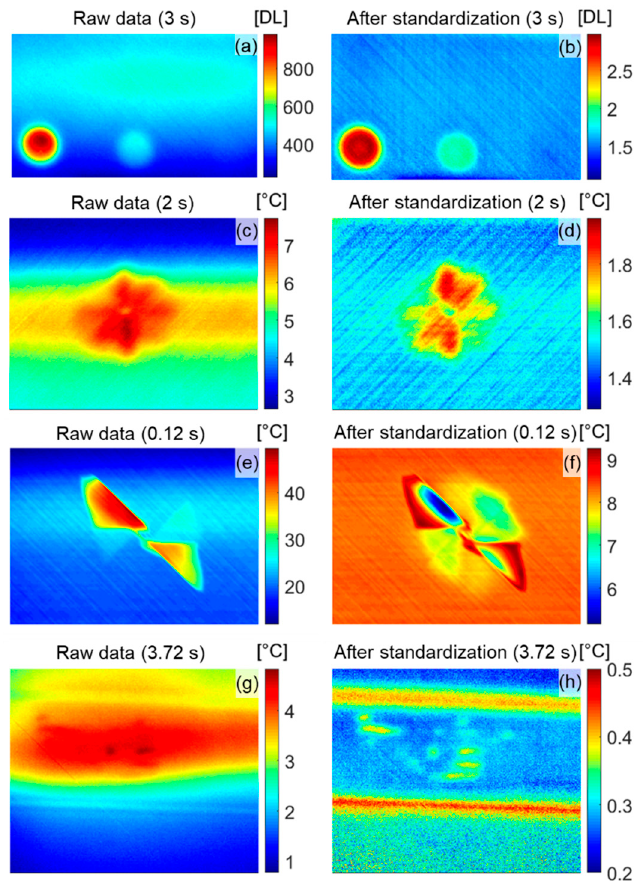
Figure 3. Thermogram at an arbitrary time instance before and after standardization for the ( a , b ) CFRP FBH coupon; ( c , d ) impacted side of the CFRP BVID coupon; ( e , f ) back side of the CFRP BVID coupon; and ( g , h ) CFRP PROD aircraft panel.